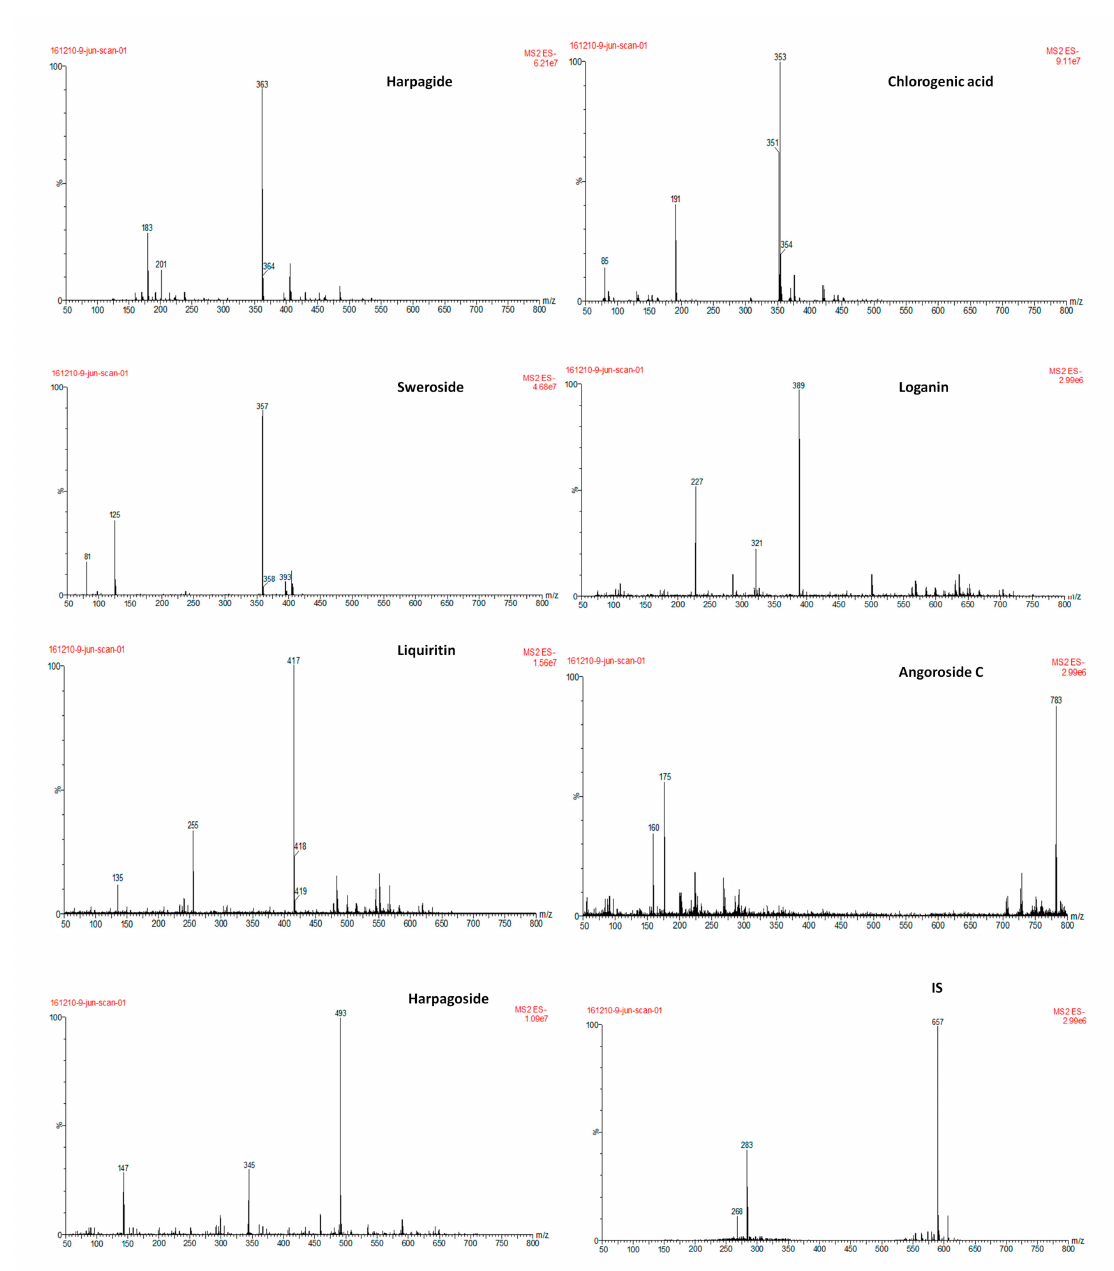
Figure 4. Product ion mass spectra of the analytes and